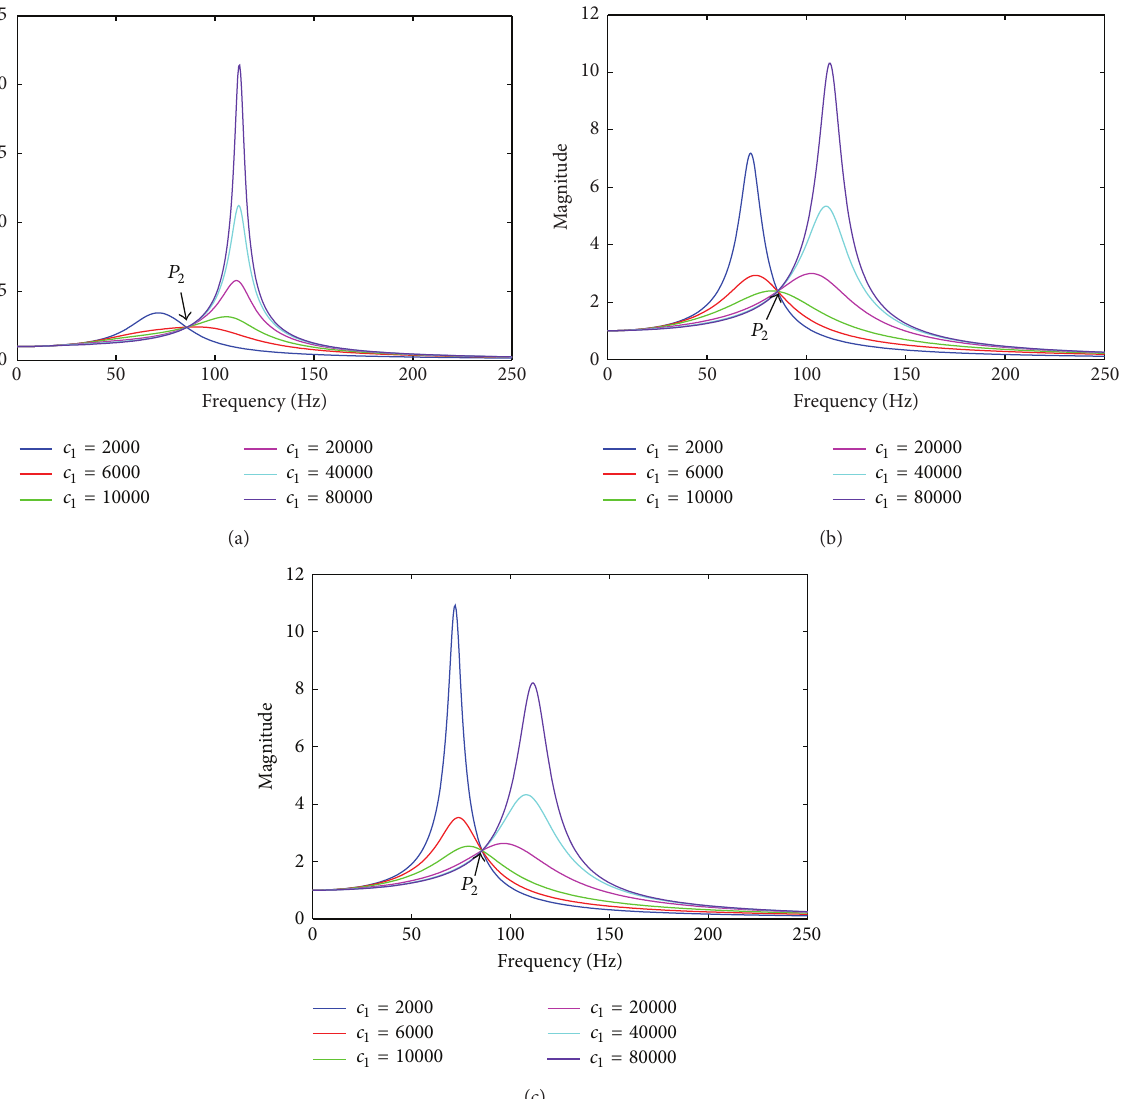
Figure 15: Absolute displacement transmissibility curves of GNM under 5.07 mm FDE cases. (a) 𝑛 1 = 1.5 ; (b) 𝑛 1 = 1 Maxwell model; (c) 𝑛 1 = 0.85